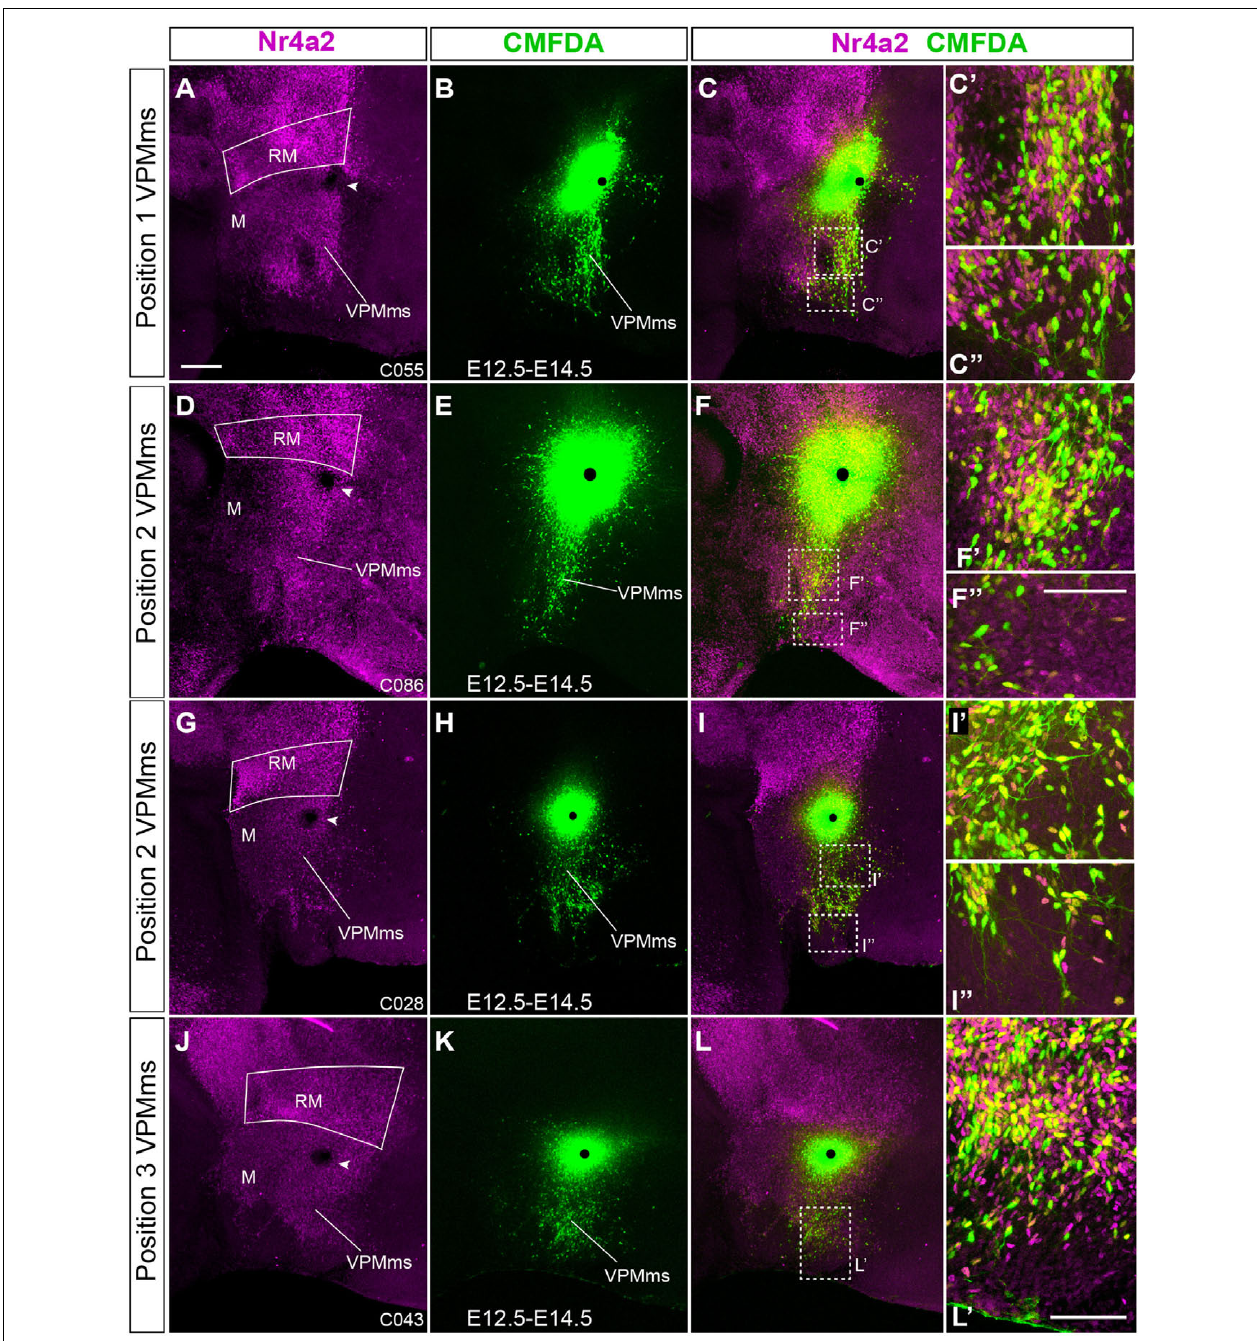
FIGURE 10 | Examples of E12.5-E14.5 cases marked within the VPMms proper. (A–C,D–F,G–I,J–L) illustrate each complete case. (A,D,G,J) Nr4a2 immunofluorescence in magenta; the arrowhead indicates the labeling site. (B,E,H,K) CMFDA signal corresponding to each case; the black dots indicate the labeling sites. (C,F,I,L) Superposed images of the two channels (Nr4a2 and CMFDA). (C’,C”, F’,F”, I’,I”,L’) Higher magnification details of immunofluorescent typology of the marked migrated cells taken at the sites boxed-in in (C,F,I,L) . Yellow cells co-localize both Nr4a2 and CMFDA signals, indicating migrated Nr4a2 cells. Magenta cells are also migrated Nr4a2 cells which were not labeled in this experiment. Green cells are labeled migrated cells that do not express Nr4a2 (i.e., they express Foxa1 or another marker). Note we do not see the theoretically present unlabeled cells lacking Nr4a2 signal. Scale bar in (A) represents 200 µ m, valid for (D , G , J) . Scale bar in (F”) represents 100 µ m being the same for (C’,C”, F’,I’,I”) . Scale bar in (L’) represents 100 µ m.